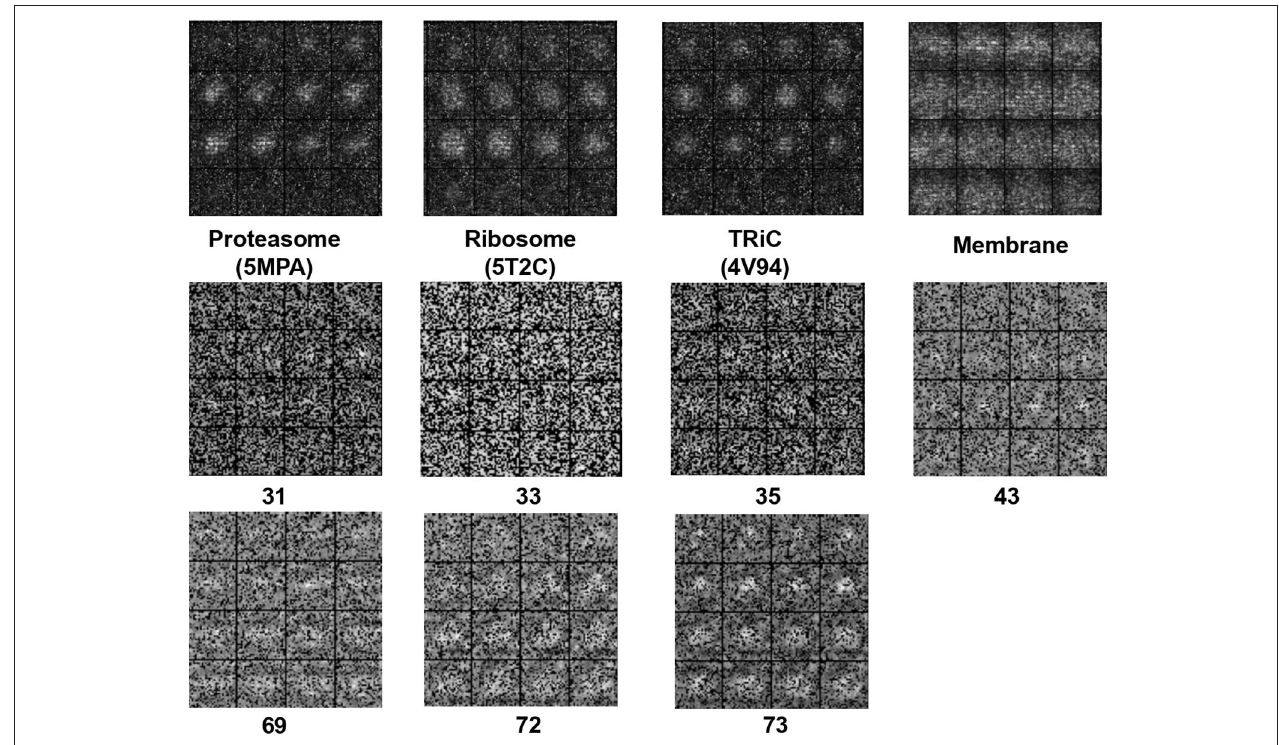
FIGURE 4 | The 2D slide visualization of uncertainty map for ( Top : S e 1 , Middle and Bottom : S e 2 ).